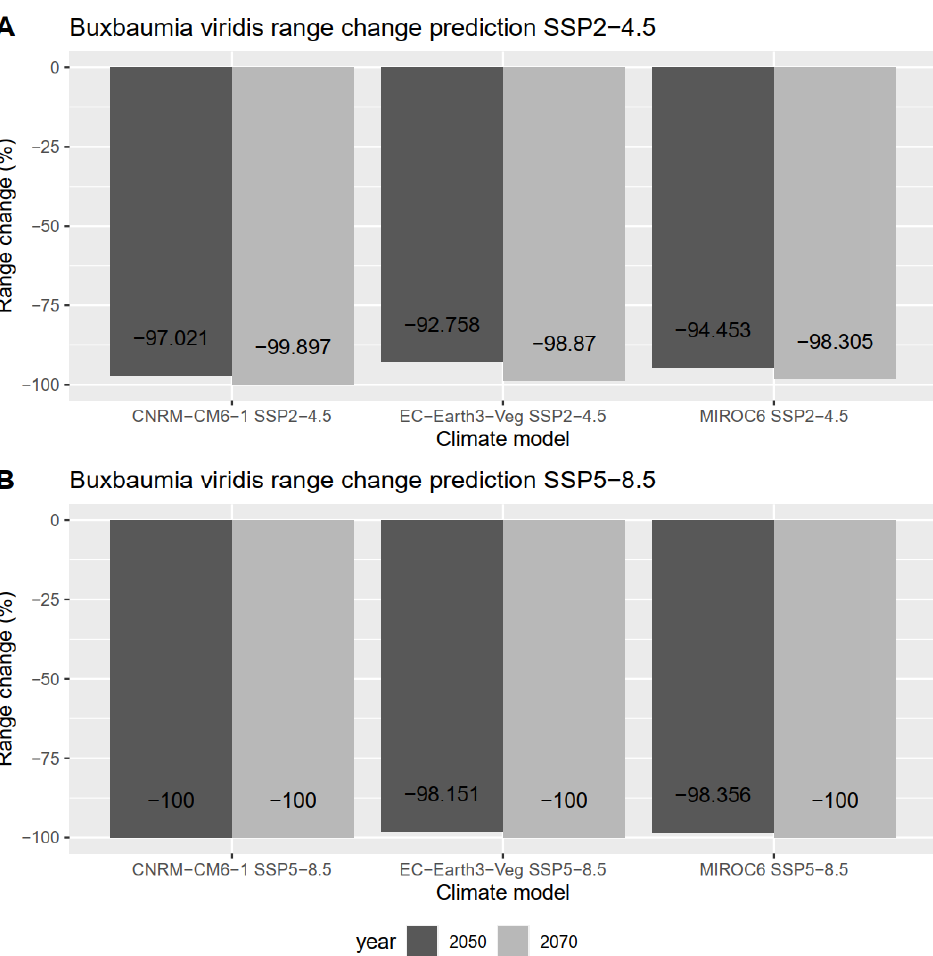
Figure 4. Percentage of projected range change/loss of Buxbaumia viridis for two reference periods (2050s and 2070s) under different GCMs and SSP scenarios (A – SSP 2-4.5 and B – SSP 5-8.5). Bars indicate values for the most accurate ensemble modeling strategy (median of probabilities).